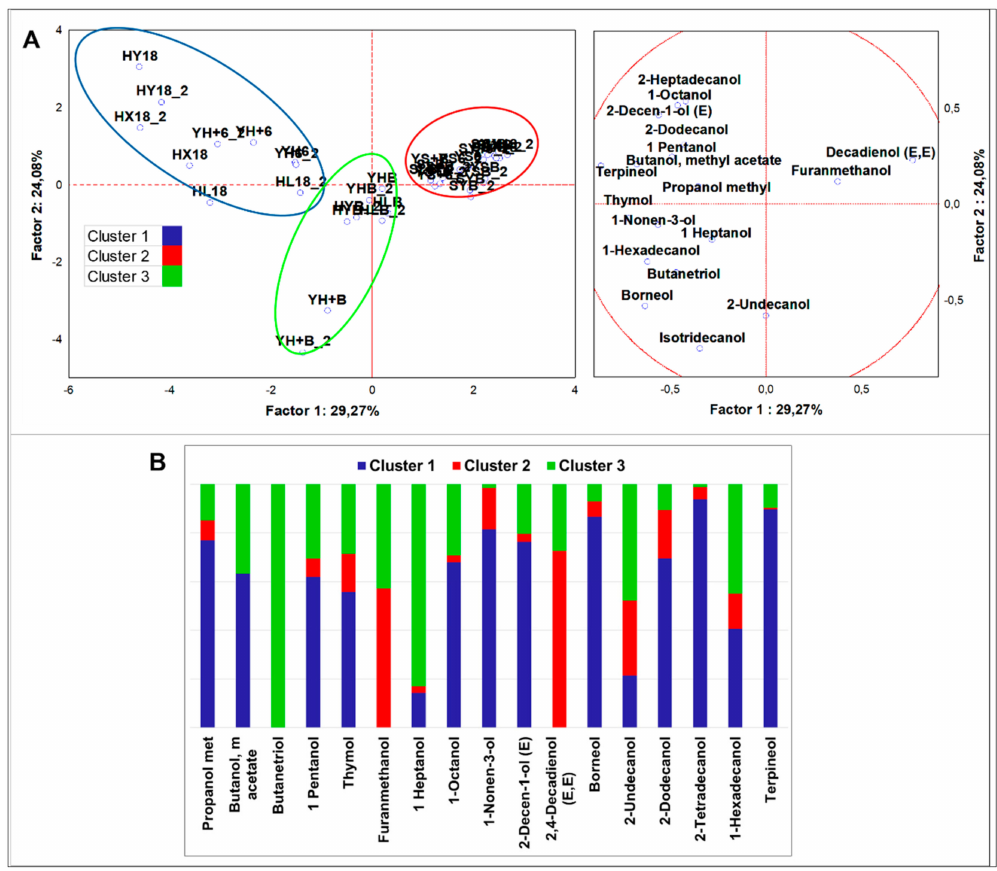
Figure 2. ( A ) Principle component analysis (PCA) of cases and variables on alcohols ( p < 0.05); ( B ) K-means clustering analysis (at least p <